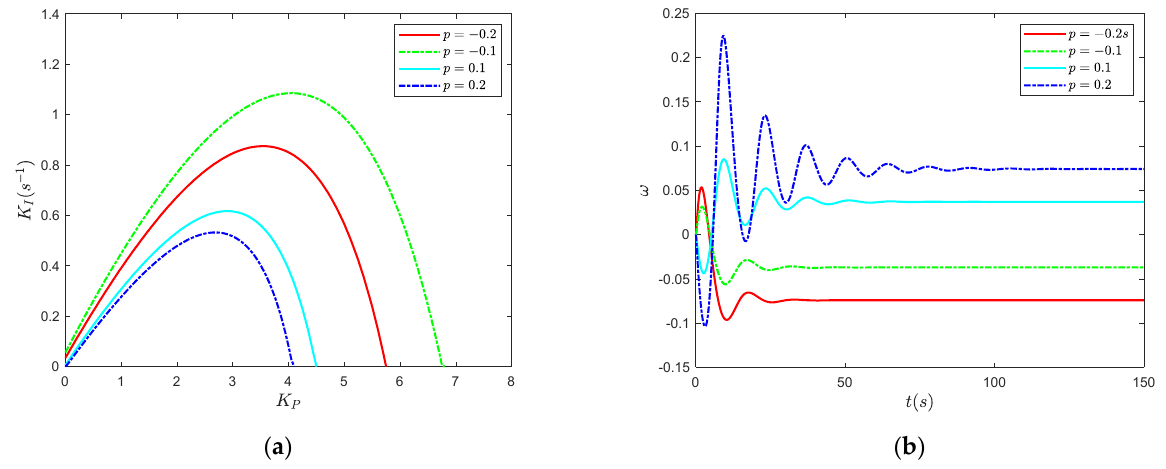
Figure 13. Effect of p on stability and dynamic characteristics: ( a ) Stable region; ( b ) Dynamic response.